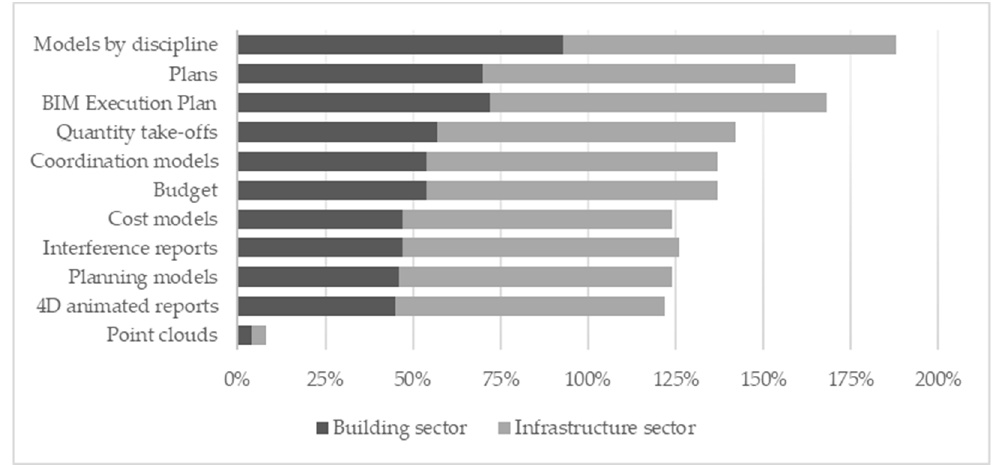
Figure 6. Inclusion of BIM deliverables in contracts by sectors. Source: Own elaboration based on [33].